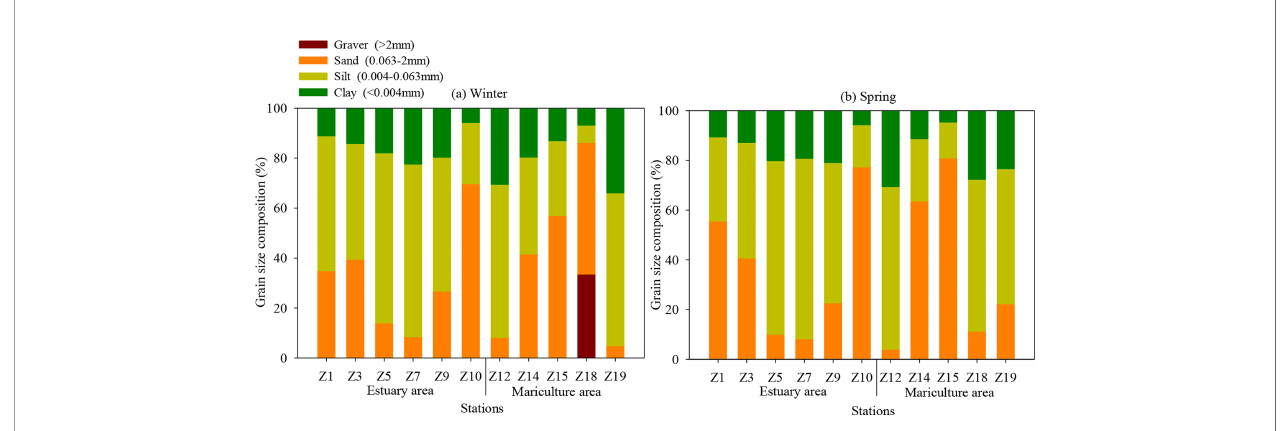
FIGURE 4 | Seasonal and spatial variations of grain size composition in the surface sediment of the estuary and mariculture area in Qinzhou Bay.